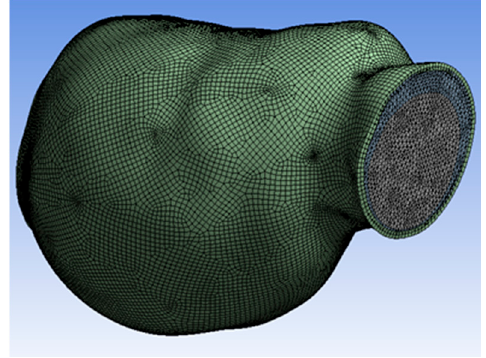
Figure 3. Meshed